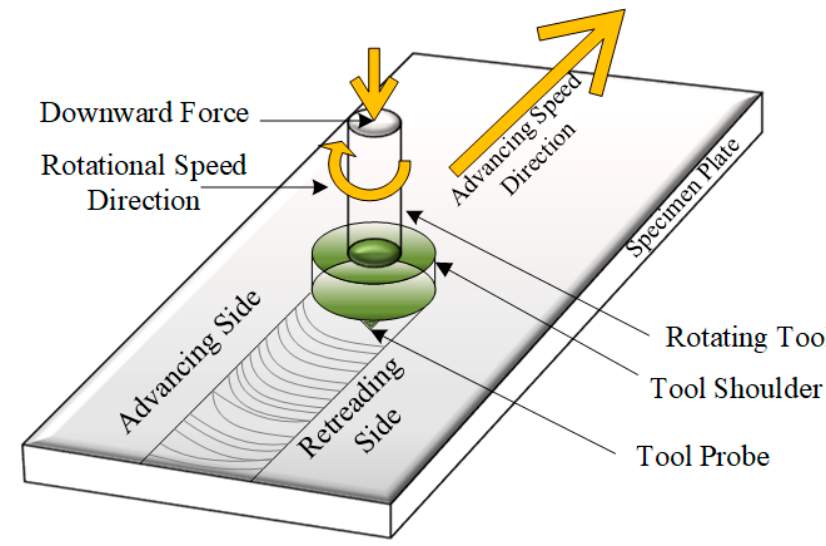
Figure 1. Friction stir processing (FSP) Representation.